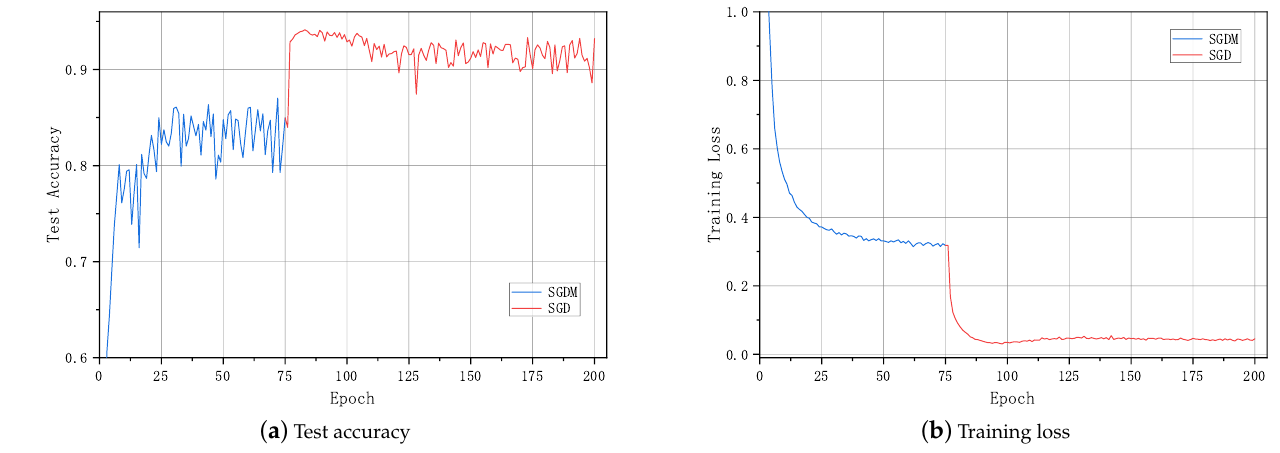
Figure 2. The test accuracy and training loss for ResNet18 on CIFAR10.